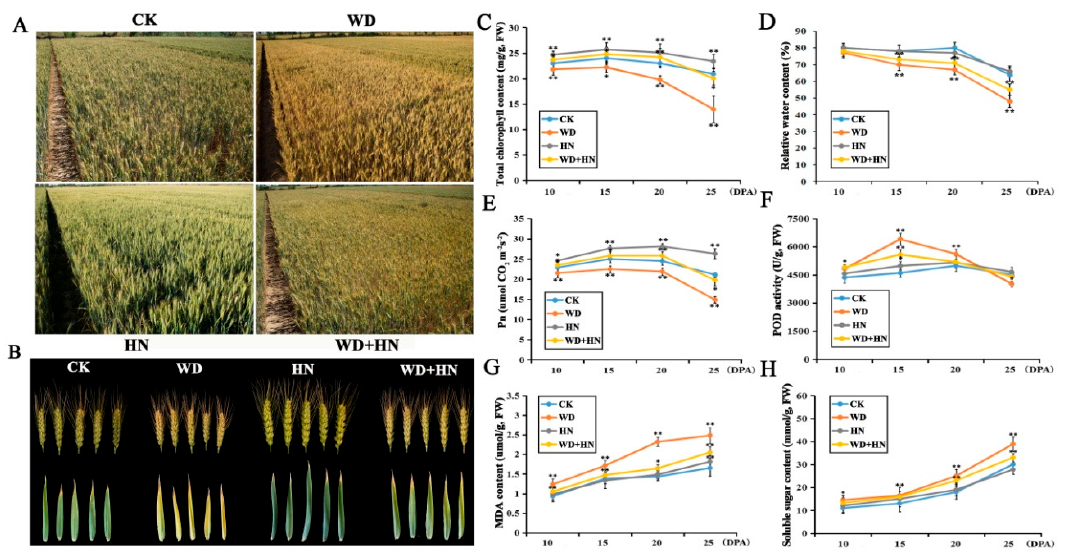
Figure 1. Morphological and physiological parameter changes of bread wheat cultivar Zhongmai 175 under control, water-deficit, high-nitrogen (N) fertilization, and combined treatments. ( A ) The field performance of wheat from di ff erent treatment groups at 25 days post-anthesis (DPA). ( B ) The performance of spikes and flag leaves. ( C – H ) Physiological parameter changes. CK: control treatment with regular watering and N fertilization; WD: water deficit treatment with no watering and regular N fertilization; HN: high-N treatment with regular watering and high-N fertilization; WD + HN: combined treatment with no watering and high-N fertilization; MDA, malondialdehyde; Pn, net photosynthesis e ffi ciency; POD, peroxidase. Significant di ff erences compared to the control were calculated based on independent Student’s t -tests: * p < 0.05; ** p < 0.01.